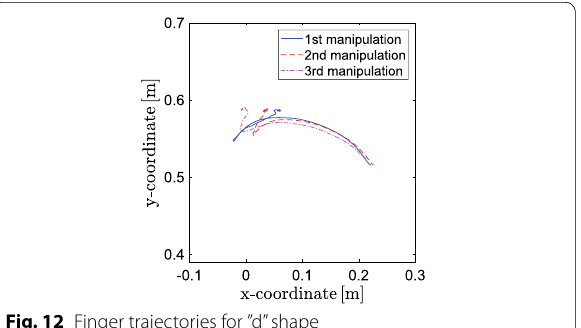
Fig. 12 Finger trajectories for ”d”